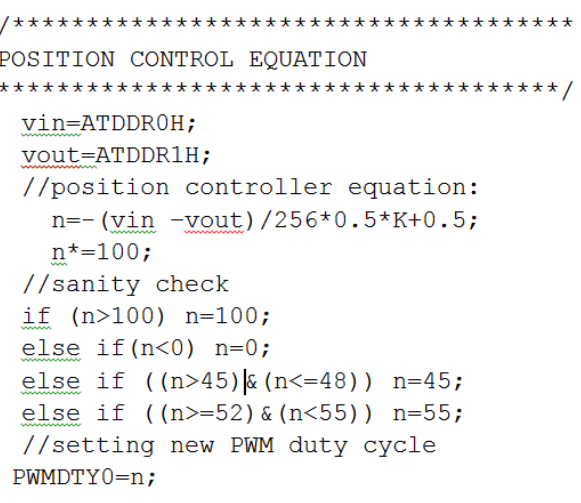
Figure 9. Control algorithm code